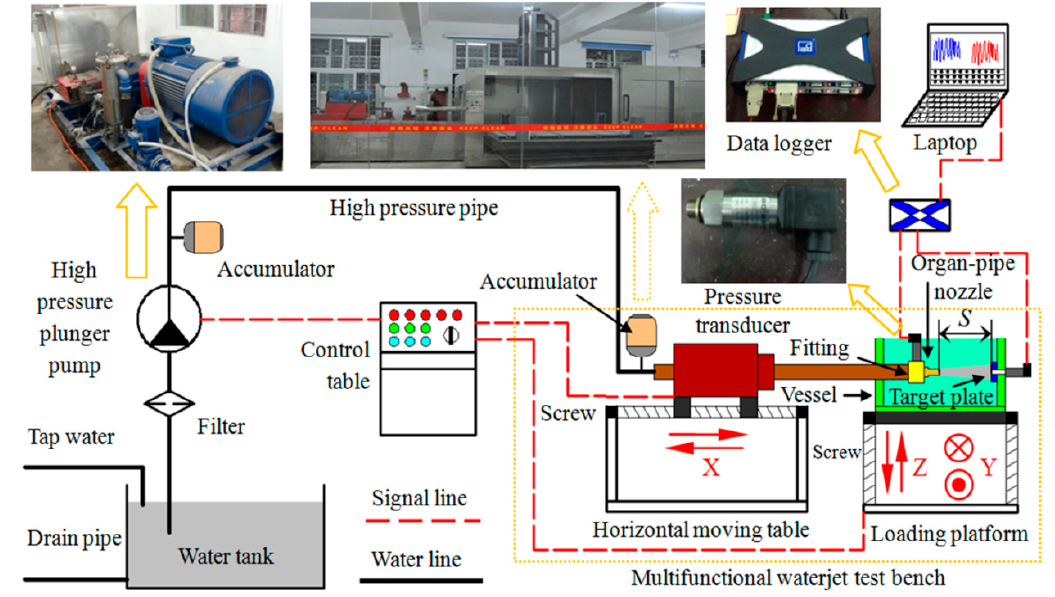
Figure 2. Experimental setup of the axial pressure measurement [20,23,25,26,33].